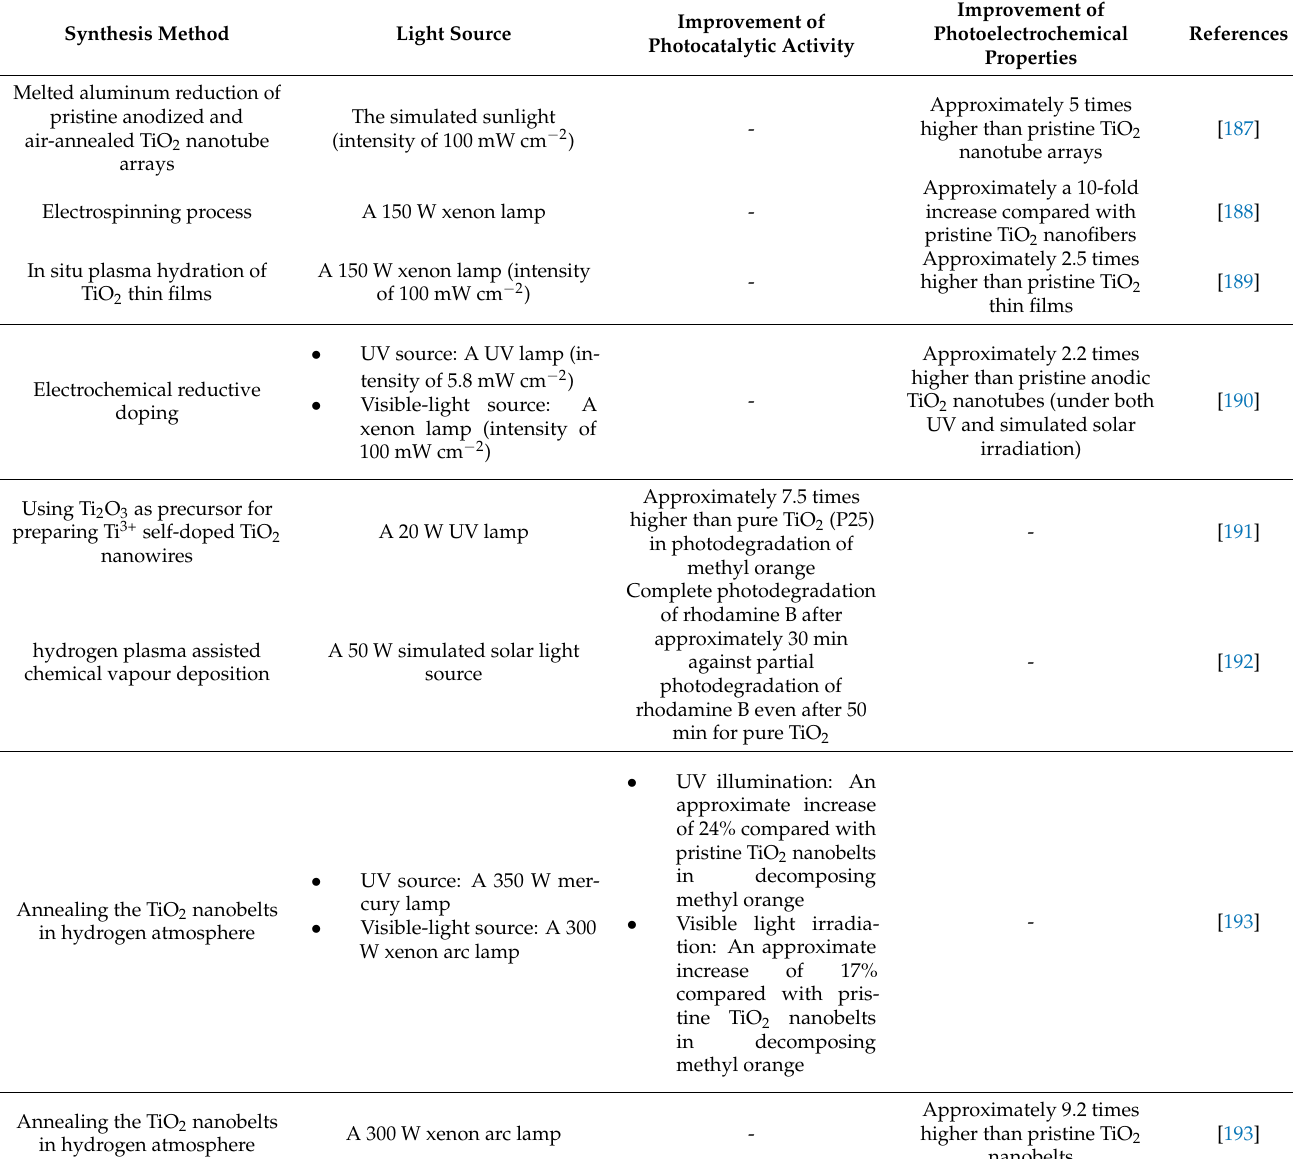
Table 3. Superior photocatalytic and photoelectrochemical properties of black TiO 2 than white TiO 2 in some case